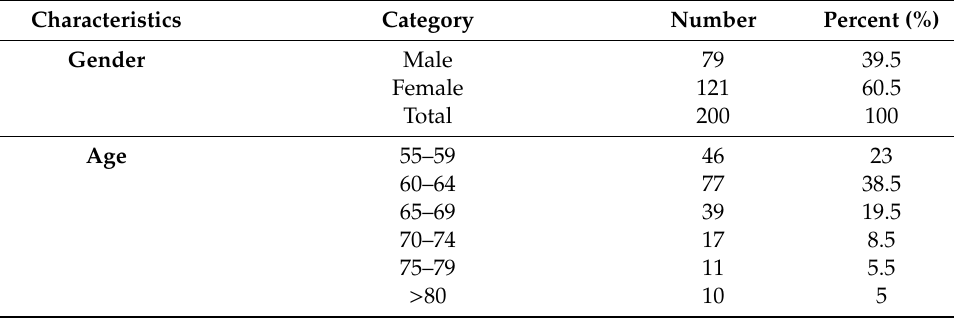
Table 1. The characteristics of the study respondents ( n =